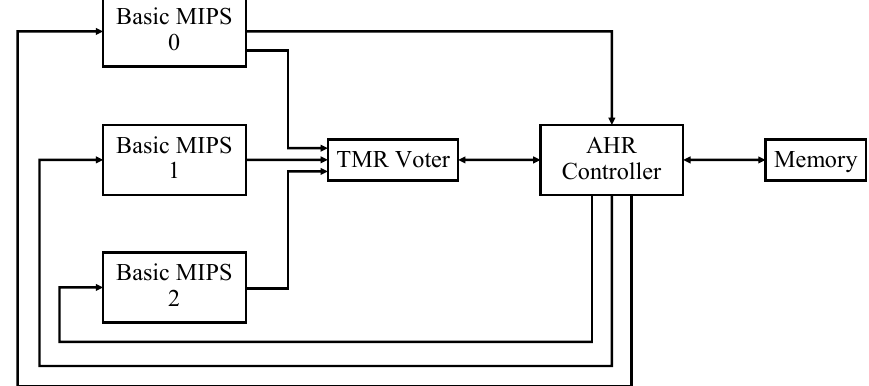
Figure 3. AHR MIPS simplified block diagram.